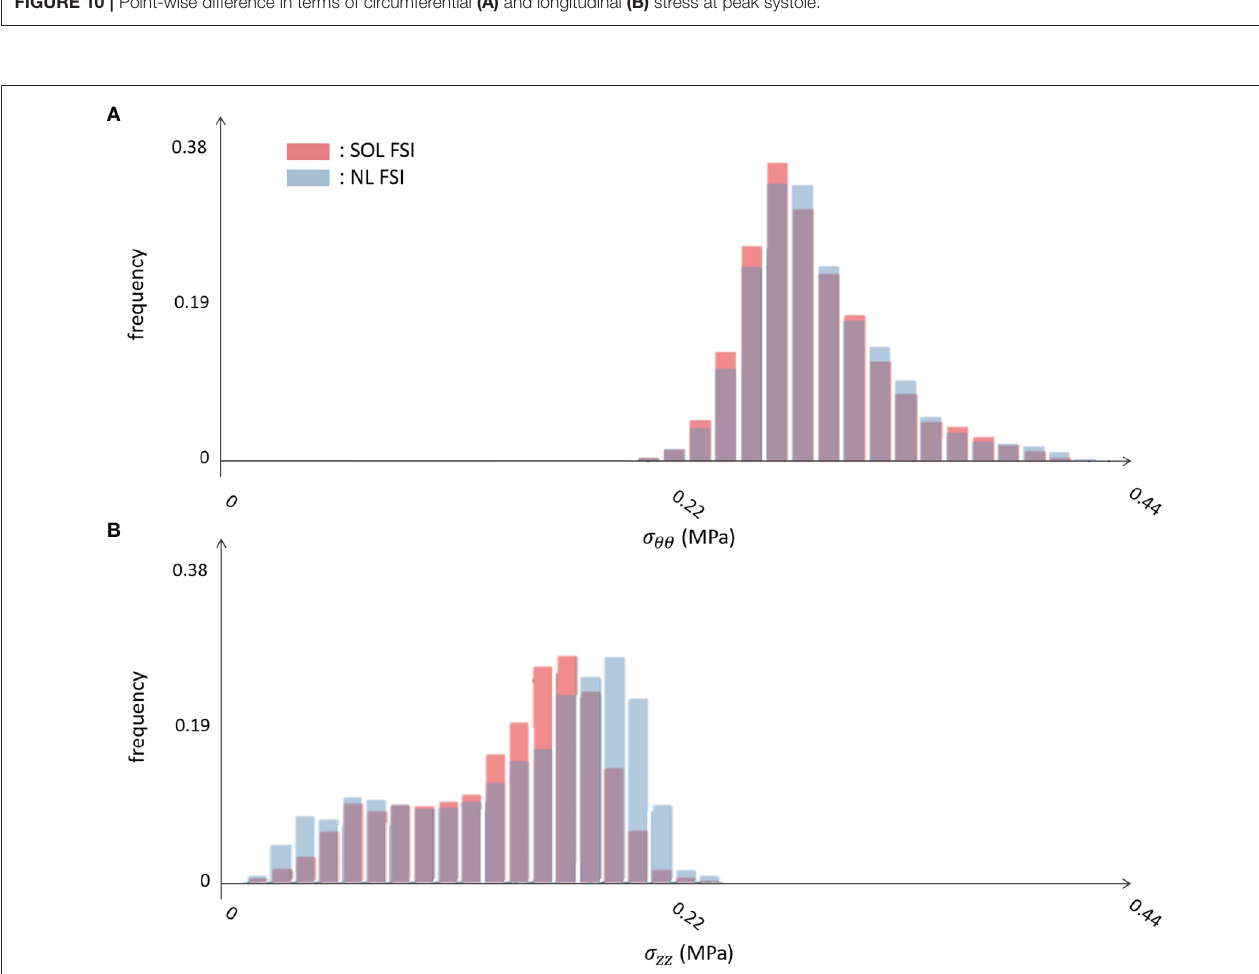
FIGURE 11 | Comparison of distributions, according to the SOL and non-linear FSI simulations, in terms of (A) circumferential and (B) longitudinal stress in the aTAA region.